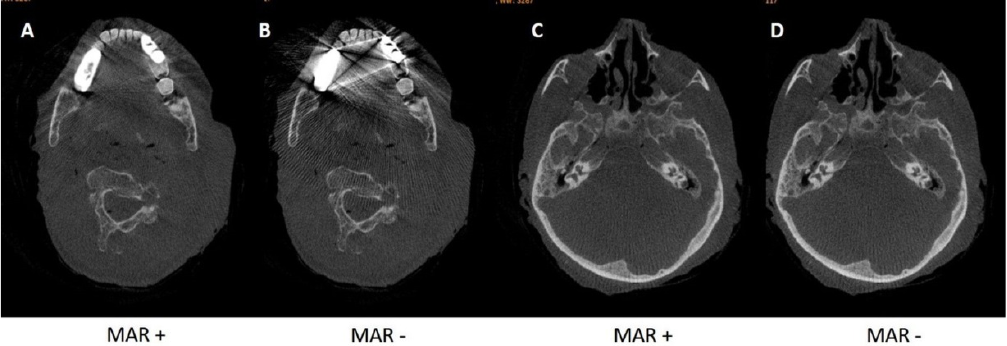
Figure 2. Axial slices (Scan protocol 121 kV / DL 1090), with ( + ) and without ( − ) metal artifact reduction algorithm (MAR), raw datasets. Less beam hardening artifacts visible in ( A ) than in ( B ). No miscalculation of datasets with MAR ( A and C vs. B and D )